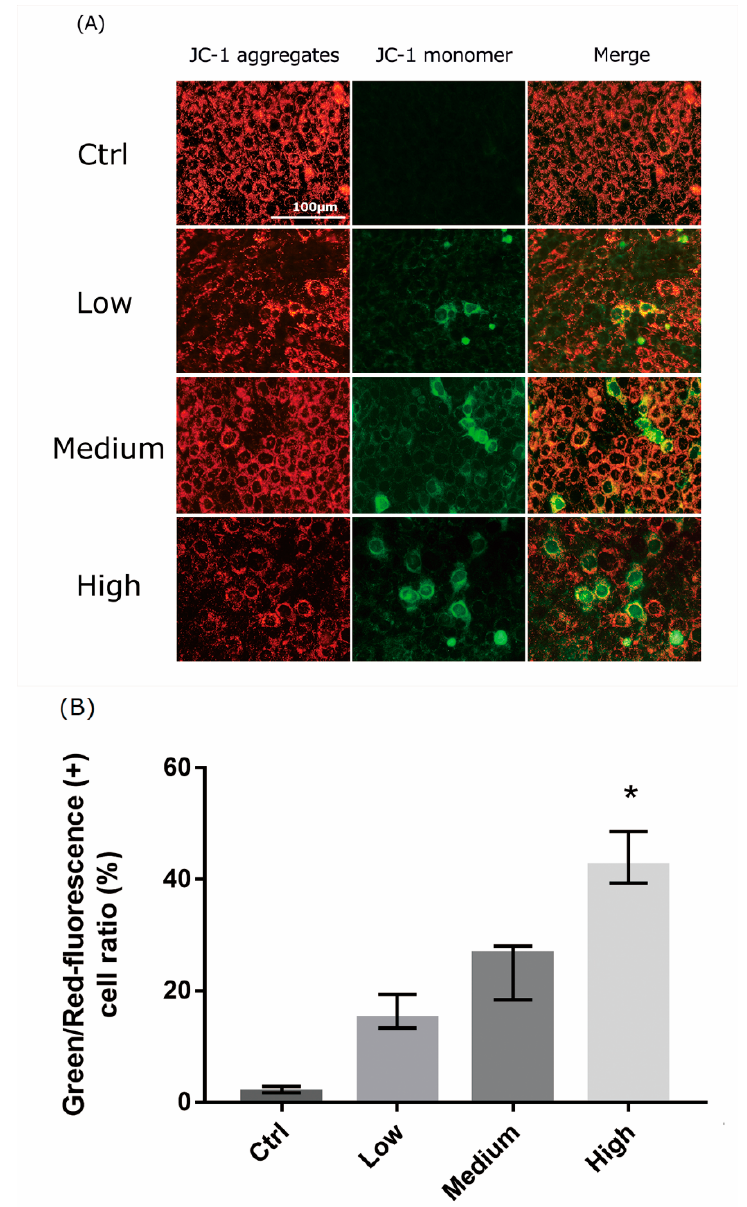
Figure 5. Liquid crystal display (LCD) exposure induces mitochondrial dysfunction in 661W cells. (A) 661W cells were subjected to JC-1 staining, which was analyzed using florescence microscopy. J-aggregates and JC-1 monomers were detected with settings designed to detect Texas Red and FITC, respectively. The 3-day exposure to LCD decreased JC-1 aggregation and increased JC-1 monomers in 661W cells. The effect was stronger in LCDs with higher ocular energy exposure index (OEEI). Bar = 100 μ m. (B) Green/Red-fluorescence (+) cell ratio (%). The numbers of cells (red or green-stained cells) were counted using image processing software (Image-J). Ctrl: control group, no light exposure; All data represent the median and the interquartile range. *p < 0.05 compared to the control group by Kurskal-Wallis test with post hoc Dunn test; n = 4 in each group.